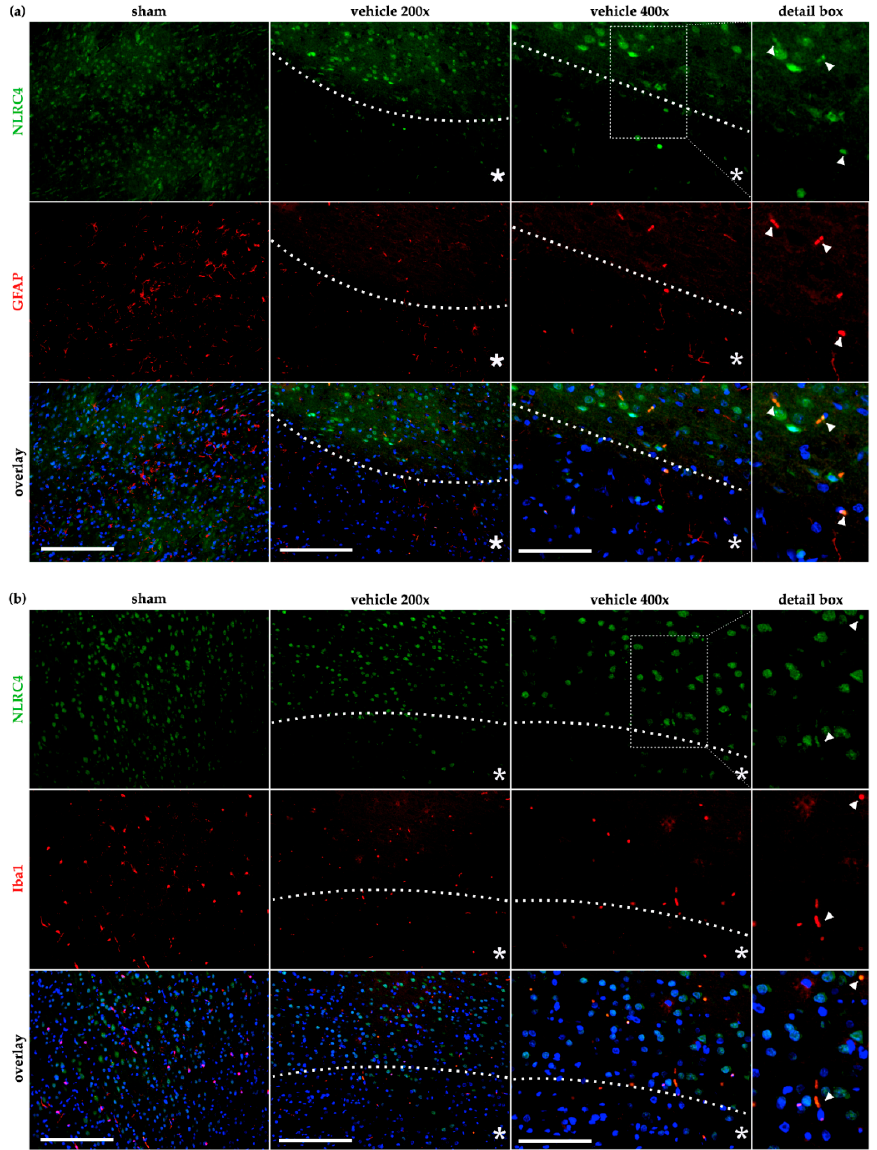
Figure 7. NLRC4 is occasionally detected in astro- and microglia cells after cerebral ischemia in rats. The co-localization of NLRC4 was evaluated by IF-co-staining in the sham and vehicle group (tMCAO + 24 h reperfusion) with astrocytes (GFAP) ( a ) and microglial cells (Iba1) ( b ). ( a ) In astrocytes, low co-localization was evident in sham animals but occasionally appeared in the peri-infarct area in the vehicle group (see 400 × magnification and the detail box). ( b ) For Iba-1 stained microglia, a similar result was observed that after cerebral ischemia, a slight amount of microglia seemed to co-localized with NLRC4 (see arrows in the detail box). Note that for proper visualization, exposure was adapted to show the co-localization between GFAP or Iba-1 positive cells with NLRC4. White bars indicate a scale of 250 µ m (200 × magnification of sham and vehicle) or 100 µ m (400 × magnification). The dashed line delineates the transition zone of the peri-infarct area around the ischemic core (asterisk). GFAP–glial fibrillary acidic protein; Iba1–ionized calcium-binding adapter molecule